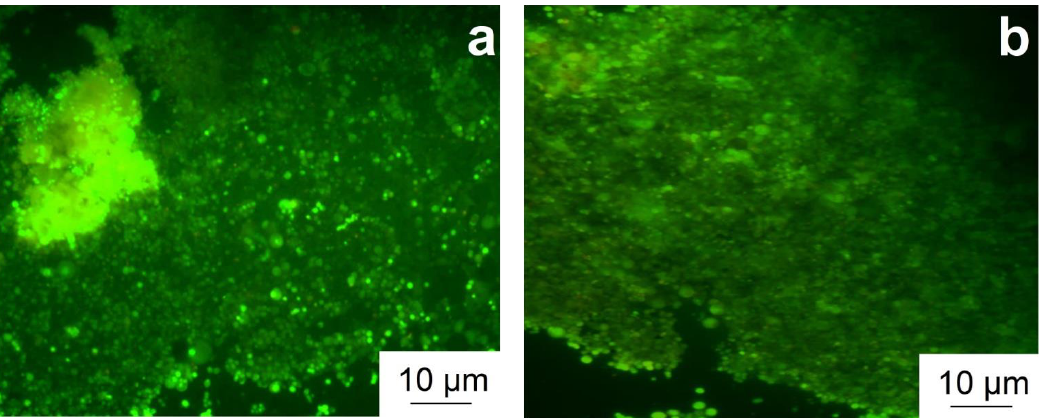
Figure 6. Growth of E. coli bacteria on the surface of samples of the annealed ( a ) and HPT-treated ( b ) alloy. Cells with a compromised membrane that are considered to be dead or dying stain red, whereas live cells with an intact membrane stain green. Cellular colonization of the surface of Zn–1%Mg alloy samples before and after HPT is shown in Figure 7.